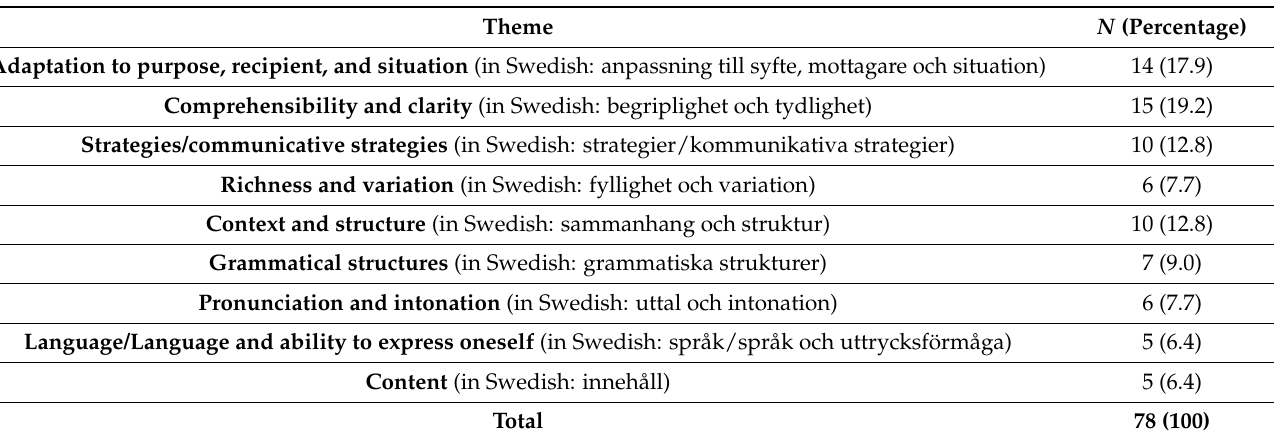
Table 3. Themes STs Y6—Number of times mentioned in categories CRITERION and ASPECT .